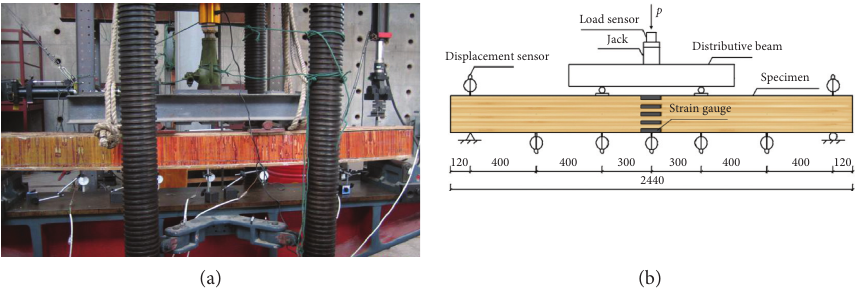
Figure 4: Test setup. (a) Photograph. (b) Diagrammatic view (all dimensions in